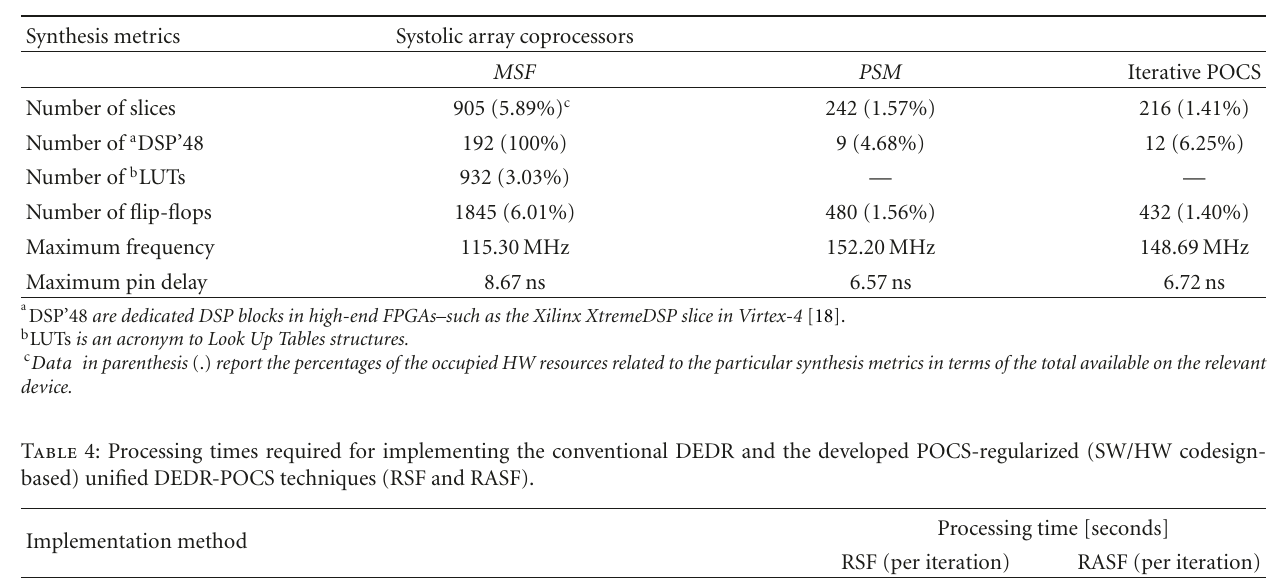
Table 3: Synthesis metrics. Specifications for data matrices of size 12 × 12 and two Band-Toeplitz PSF matrices of the same 12 × 12 pixel size with equal bandwidths of 2 κ a = 3 and 2 κ r = 3.